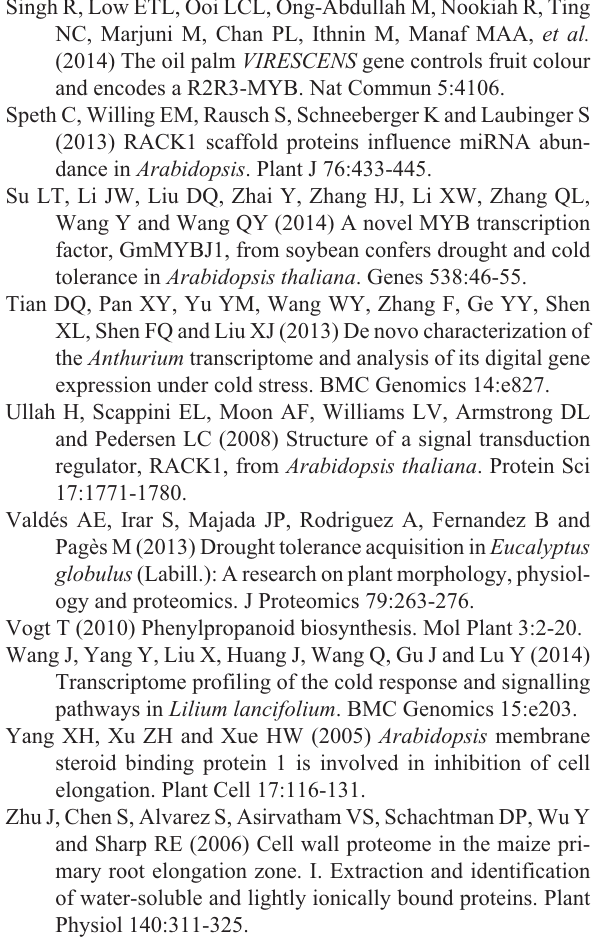
Table S1 - Experimental data for E. urograndis stem pro- tein isolation and 2D gel